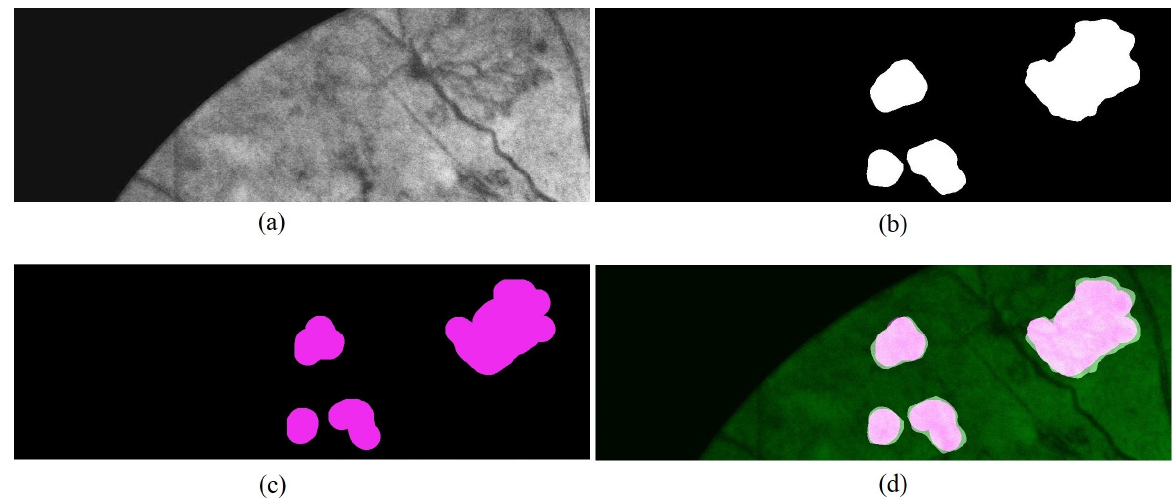
Figure 8. An example of an output image patch generated from the proposed network. ( a ) input image patch; ( b ) segmented Neo region by the network; ( c ) ground truth region; ( d ) the output image is generated by overlaying the segmented region and ground truth on the input image.